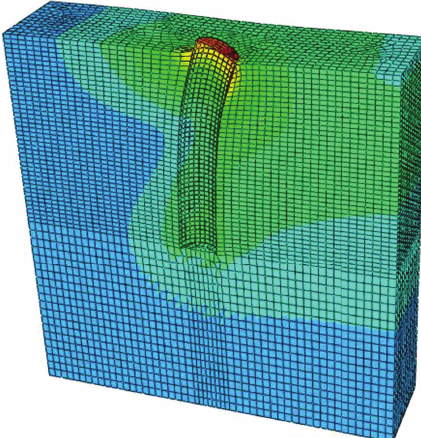
F 2: Deformation of the soil with the 3D model of the pile.